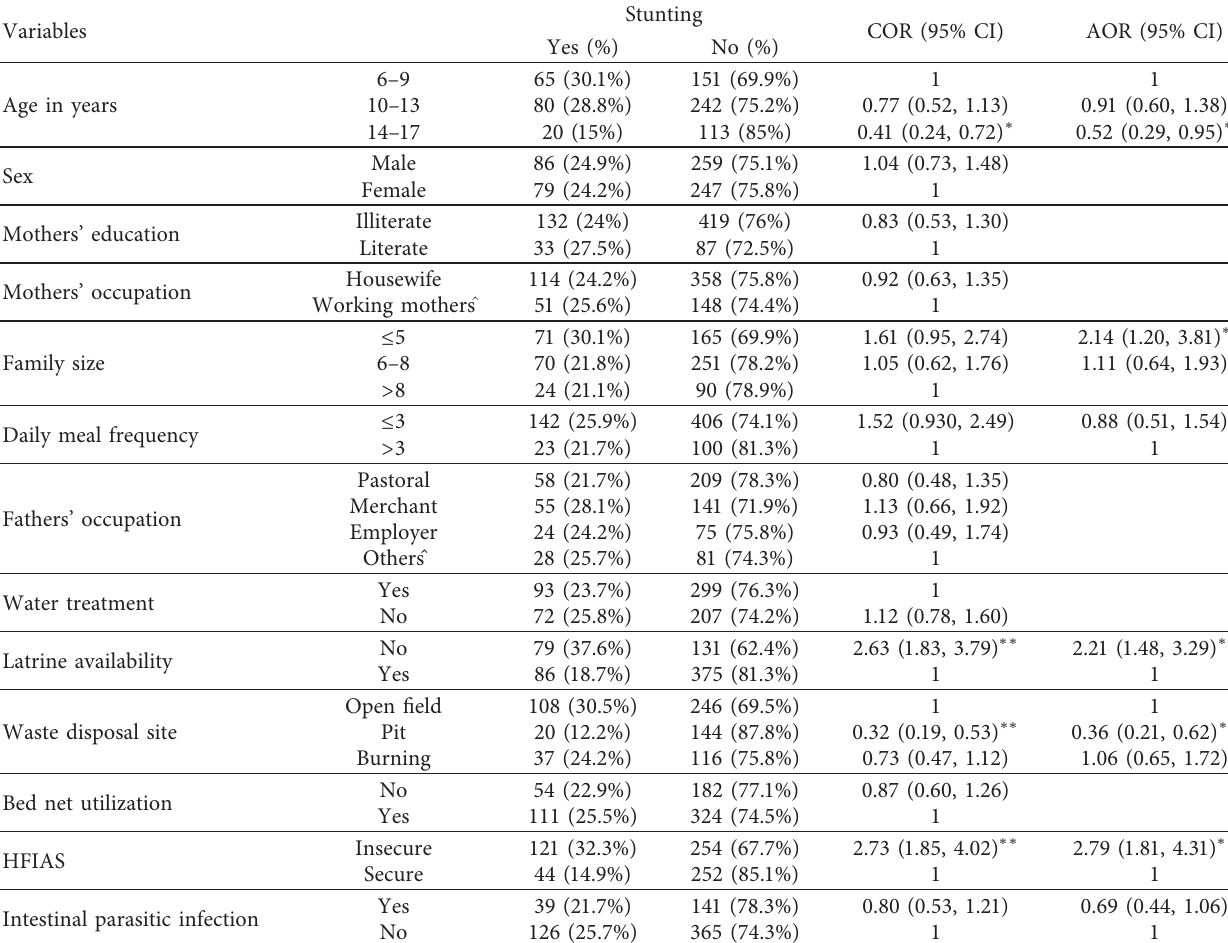
Table 3: Factors associated with stunting among children attending primary schools in pastoral communities, Mieso-Mulu district, Sitti Zone, Somali Regional State, Eastern Ethiopia,